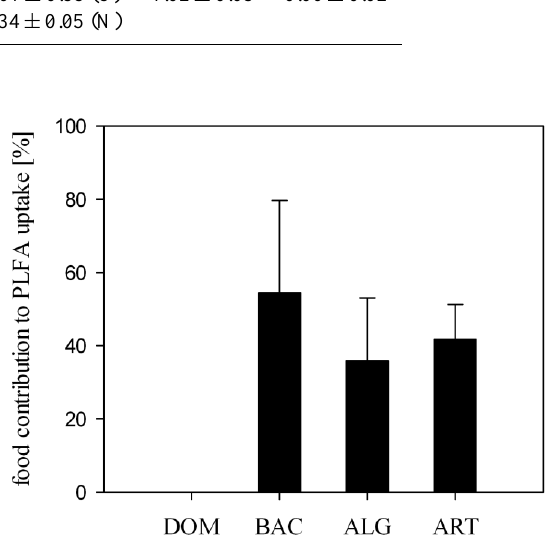
Fig. 4. Contribution of food-derived PLFAs to total PLFA synthe- sis in corals during the experiment. Based on the assumption that food-derived PLFAs are directly incorporated into animal PLFAs, the food contribution was calculated by summing the uptake in food characteristic PLFAs by L. pertusa and dividing it by its the total PLFA uptake. The bars in the figure represent average ±